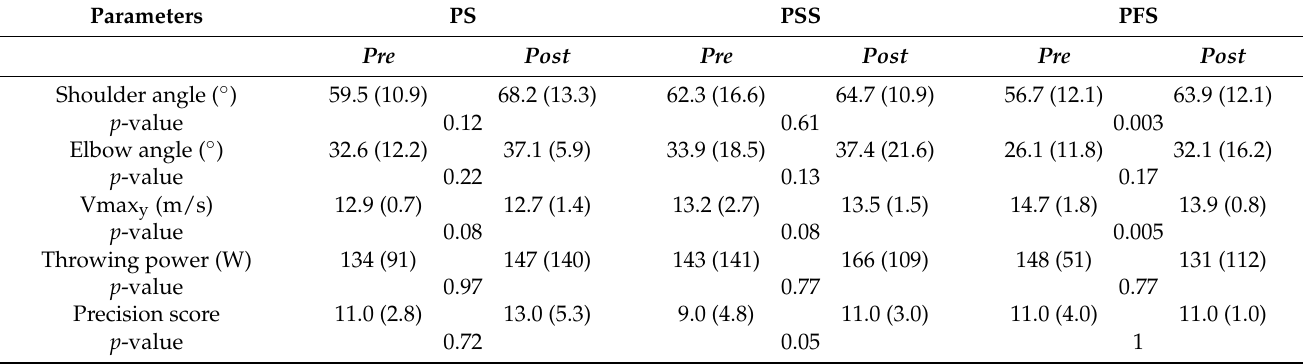
Table 1. Comparison of the biomechanical parameters. Median and interquartile range (IQR) are reported for each parameter, before ( Pre ) and after ( Post ) the training, as well as the p -values obtained from the Pre – Post comparison. Statistically significant p -values are highlighted in bold. PS: penalty shot; PSS: passing-spontaneous shot; PFS: passing-feint shot.